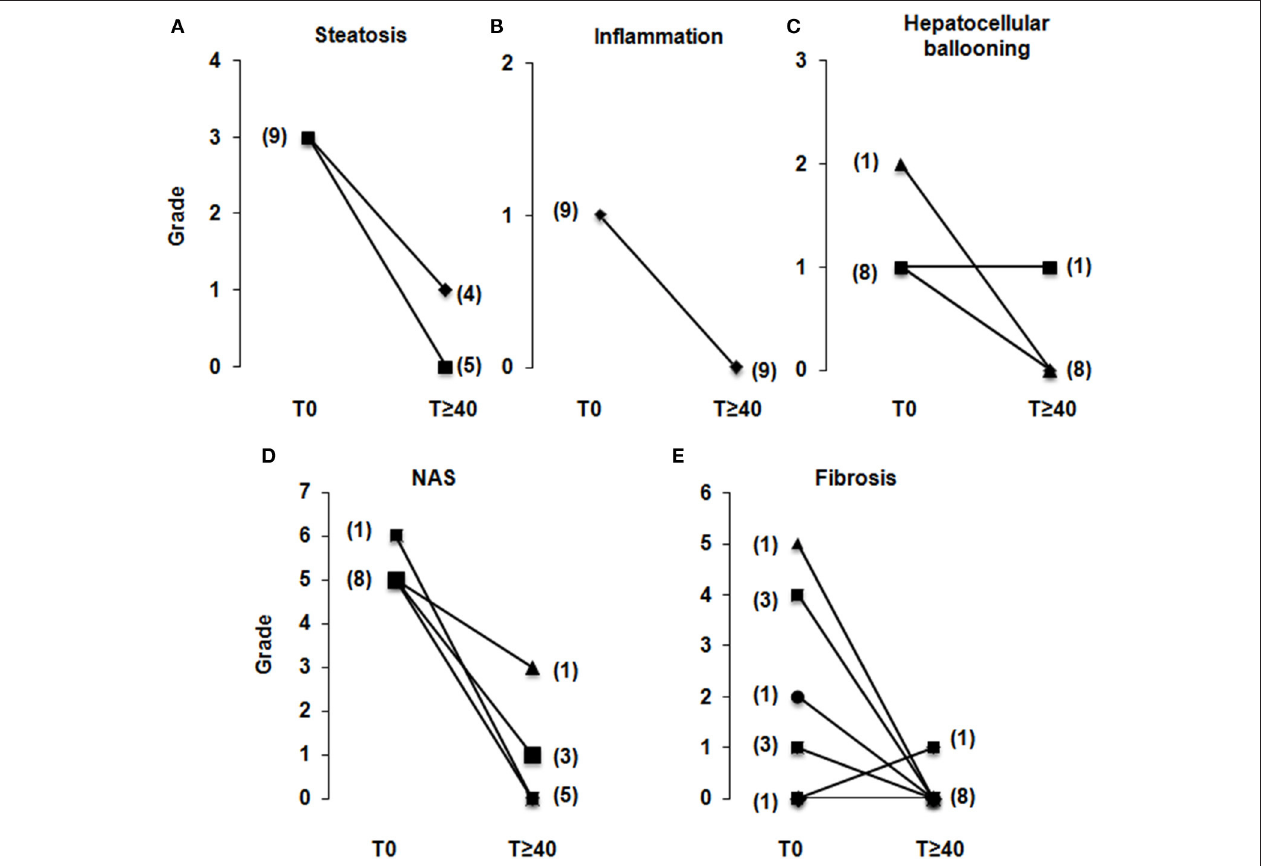
FIGURE 2 | LRYGB in NASH patients improves hepatic steatosis and inflammation in all patients, and improves hepatic fibrosis in the large majority after a median follow-up of 55 months. Nine morbidly obese patients with biopsy-proven NASH underwent LRYGB and had a second liver biopsy at a median follow-up period of 55 [44; 75] months after surgery. From the paired liver biopsies, steatosis (A) , inflammatory foci (B) , hepatocellular ballooning (C) , and fibrosis (E) were evaluated. (D) The NAFLD activity score (NAS) was evaluated as described in Section Materials and Methods. Fibrosis was semi-quantitatively evaluated